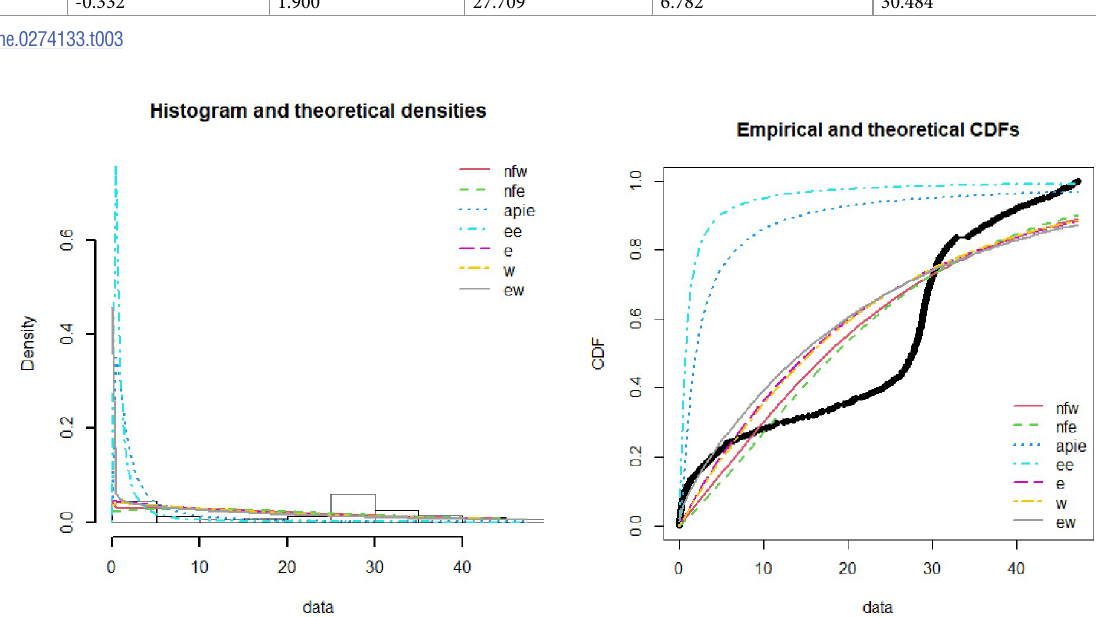
Fig 3. Theoretical and empirical PDF and CDF of